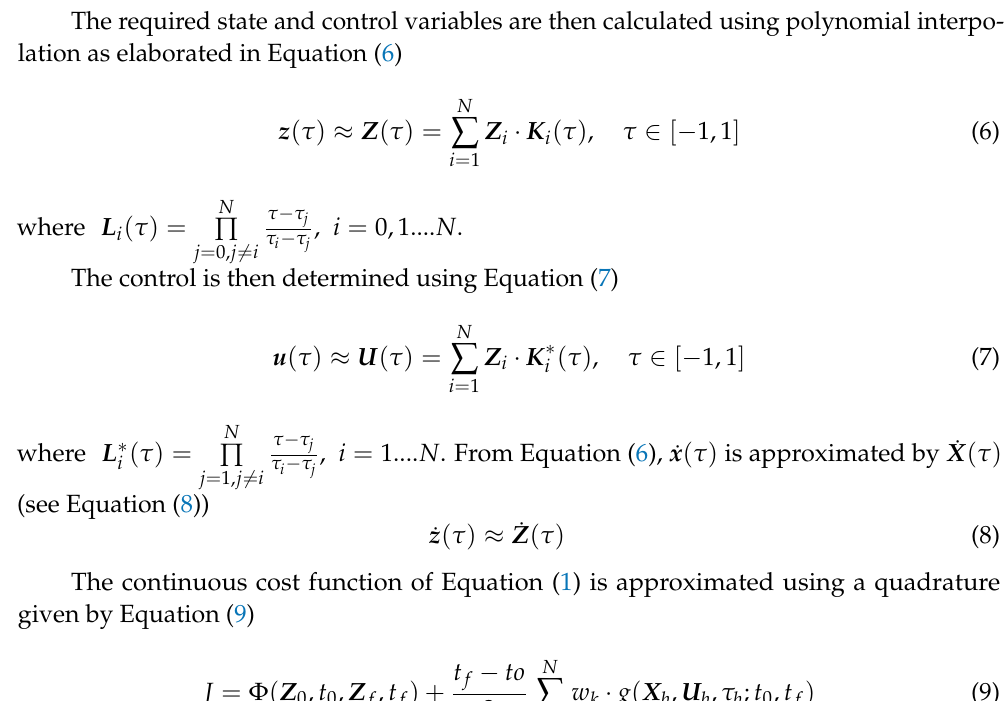
Figure 2. Conventional operational flow chart of trajectory planning